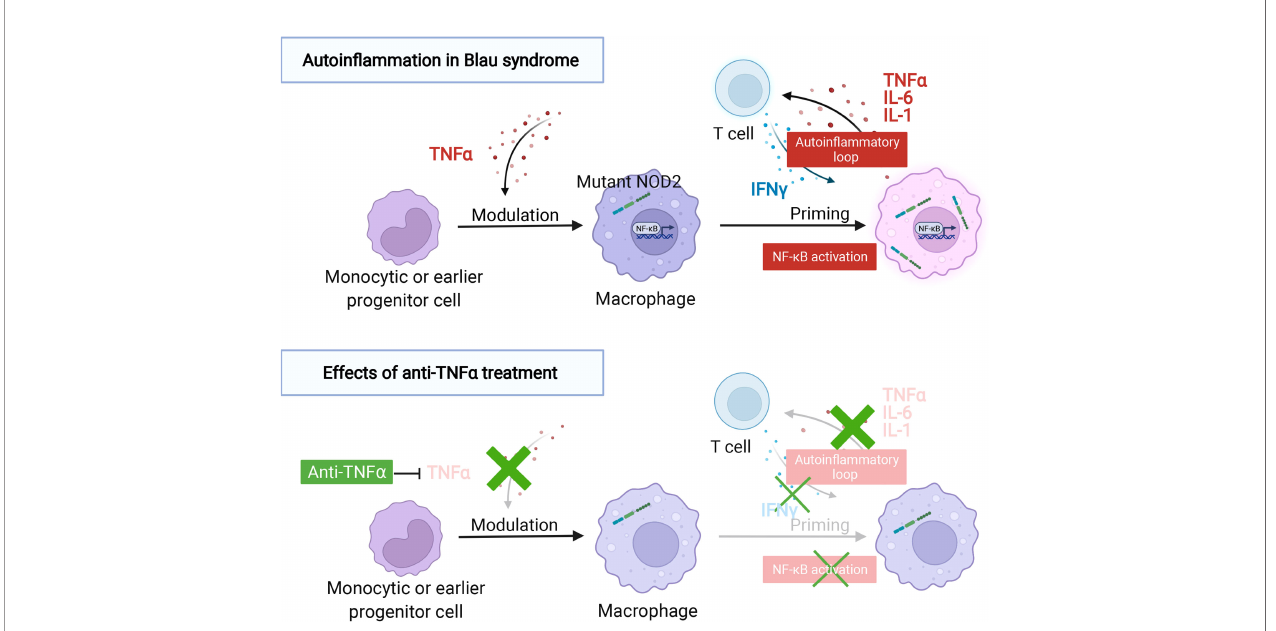
FIGURE 1 | The autoin fl ammatory response in Blau syndrome and the effect of anti-TNF a treatment. Autoin fl ammation in Blau syndrome. The expression of NOD2 is induced by IFN g with or without a NOD2 mutation. The production of proin fl ammatory cytokines, such as TNF a , IL-6, and IL-1, can only be con fi rmed in macrophages with NOD2 mutations associated with Blau syndrome, in the absence of muramyl dipeptide (MDP) that activate NOD2. These proin fl ammatory cytokines further activate T cells and induce the production of IFN g , thereby establishing a self-amplifying autoin fl ammatory loop. The effect of anti-TNF a treatment. TNF a -targeted therapy inhibits T cell activation, indirectly suppressing IFN g production in T cells, and as a result, the autoin fl ammatory loop is suppressed. Macrophages differentiated from blood collected from patients with Blau syndrome and treated with a TNF a -targeted therapy behaved similarly to wild-type NOD2-expressing cells, despite the presence of the Blau syndrome-associated NOD2 mutations. This suggests that TNF a may exert a modulatory effect on monocytic or early prongenitor cells before they are induced to differentiate into macrophages and adopt a more in fl ammation-speci fi c